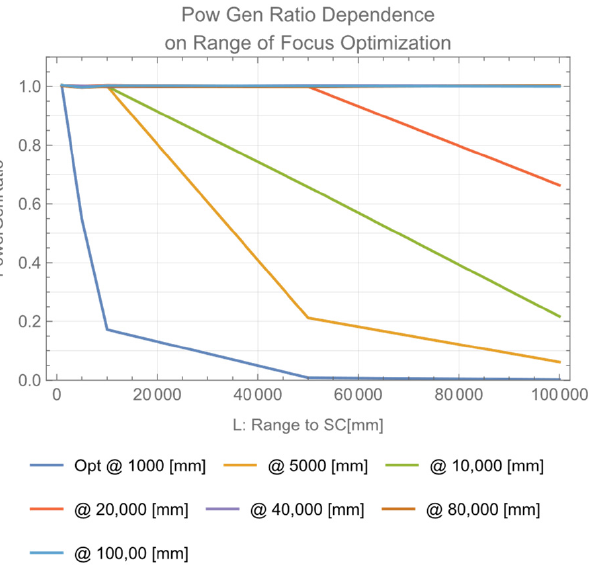
Figure 8. Range dependence of power generation ratio for various focus adjustment range.